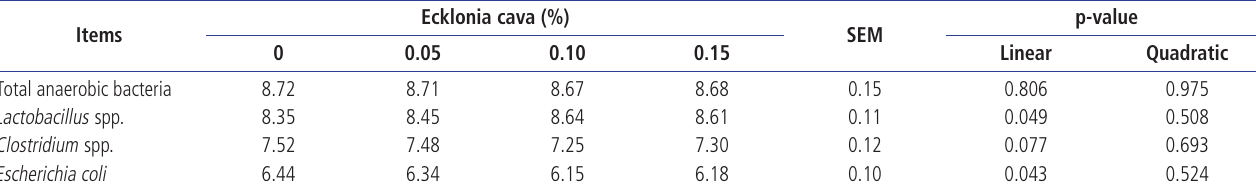
Table 5. Effects of supplemental Ecklonia cava on caecal microbial populations (Log